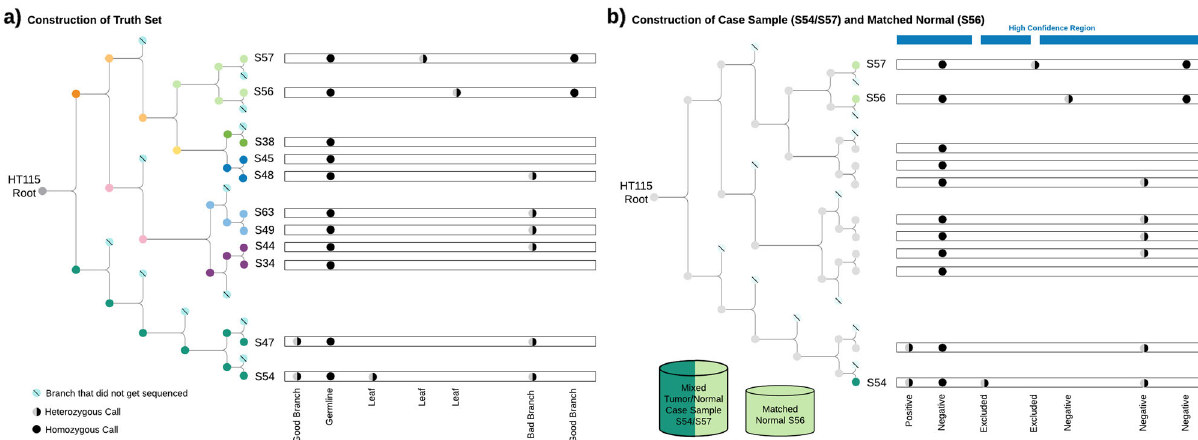
Fig. 1 Lineage tree structure for HT115 and an example genomic region. a Although most of the Good Branch Variants are heterozygous owing to single cell bottlenecks, we do observe some Good Branch Variants that are homozygous variants due to loss of heterozygosity events that occurred after the mutation arose or large scale deletions. b A case sample and matched normal are created from mixing any two samples together. A matched normal is taken from the closest relative to the mixed in normal. This results in a list of positive sites and excluded